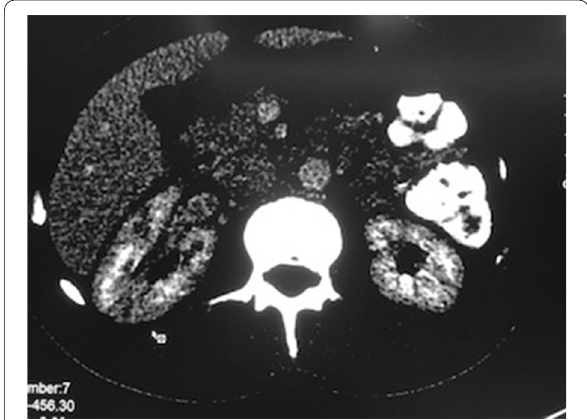
Fig. 1 Right kidney (white arrow) with axial tomography cross section compared to the left kidney, with contrast enhancement significantly reducing hypodense patchy lesion